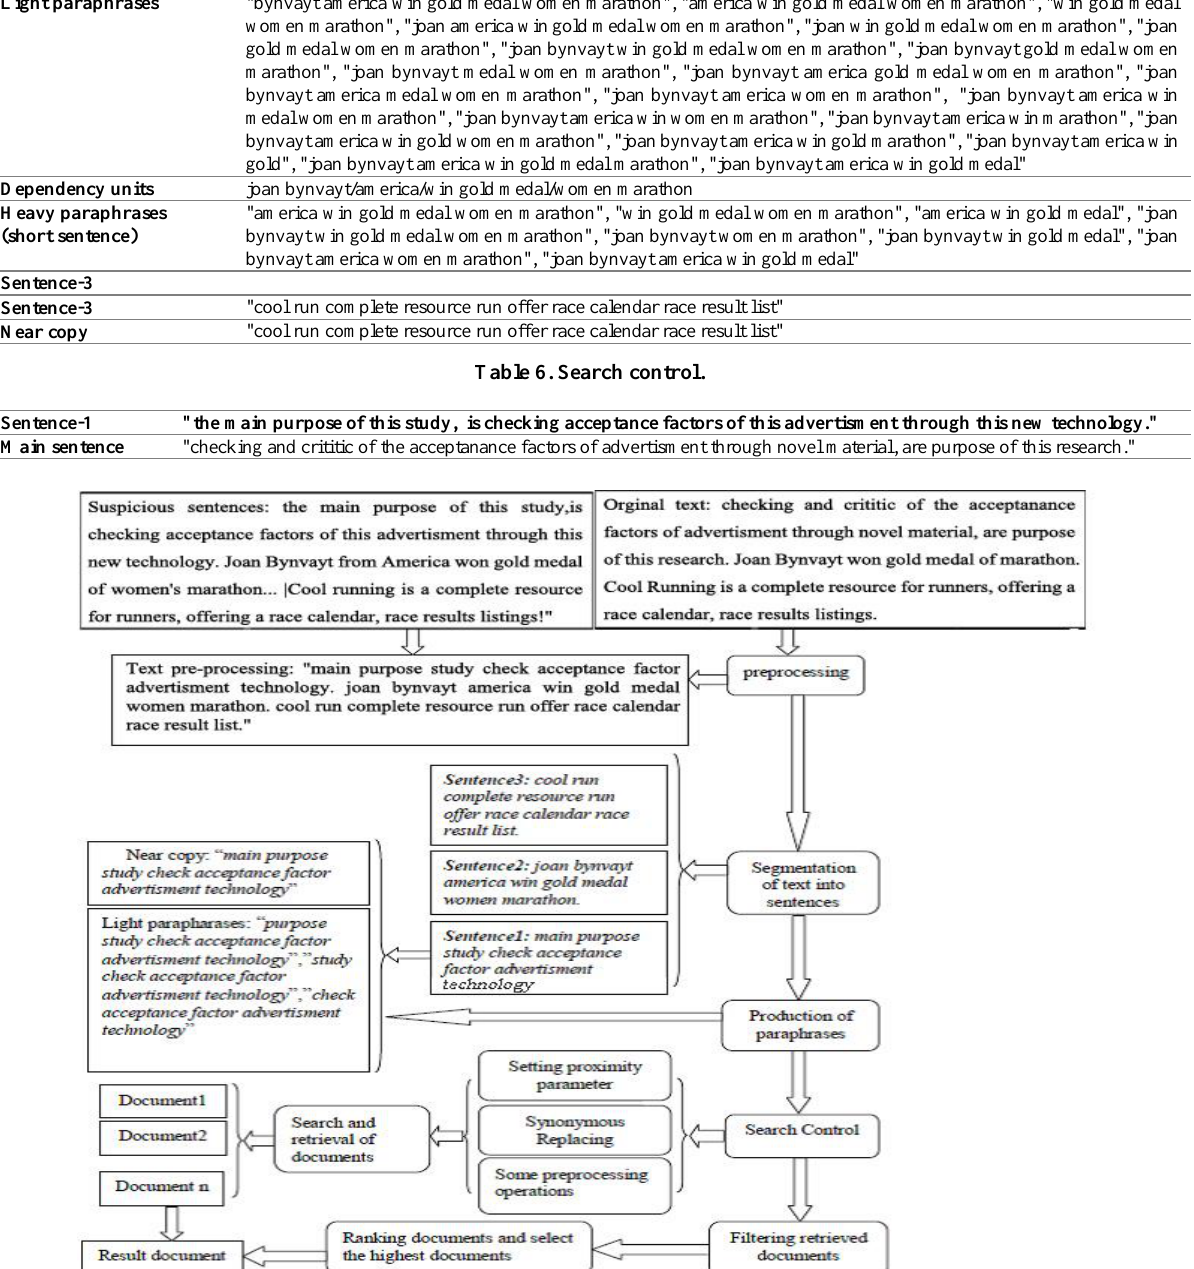
Figure 7. Case study of